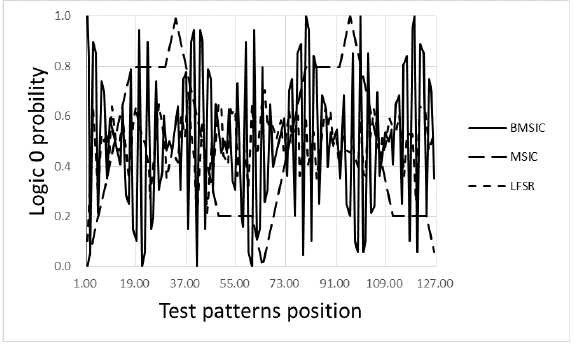
Figure 4. ( a ) Scan moving direction randomness analysis diagram. ( b ) Test pattern direction randomness analysis diagram.